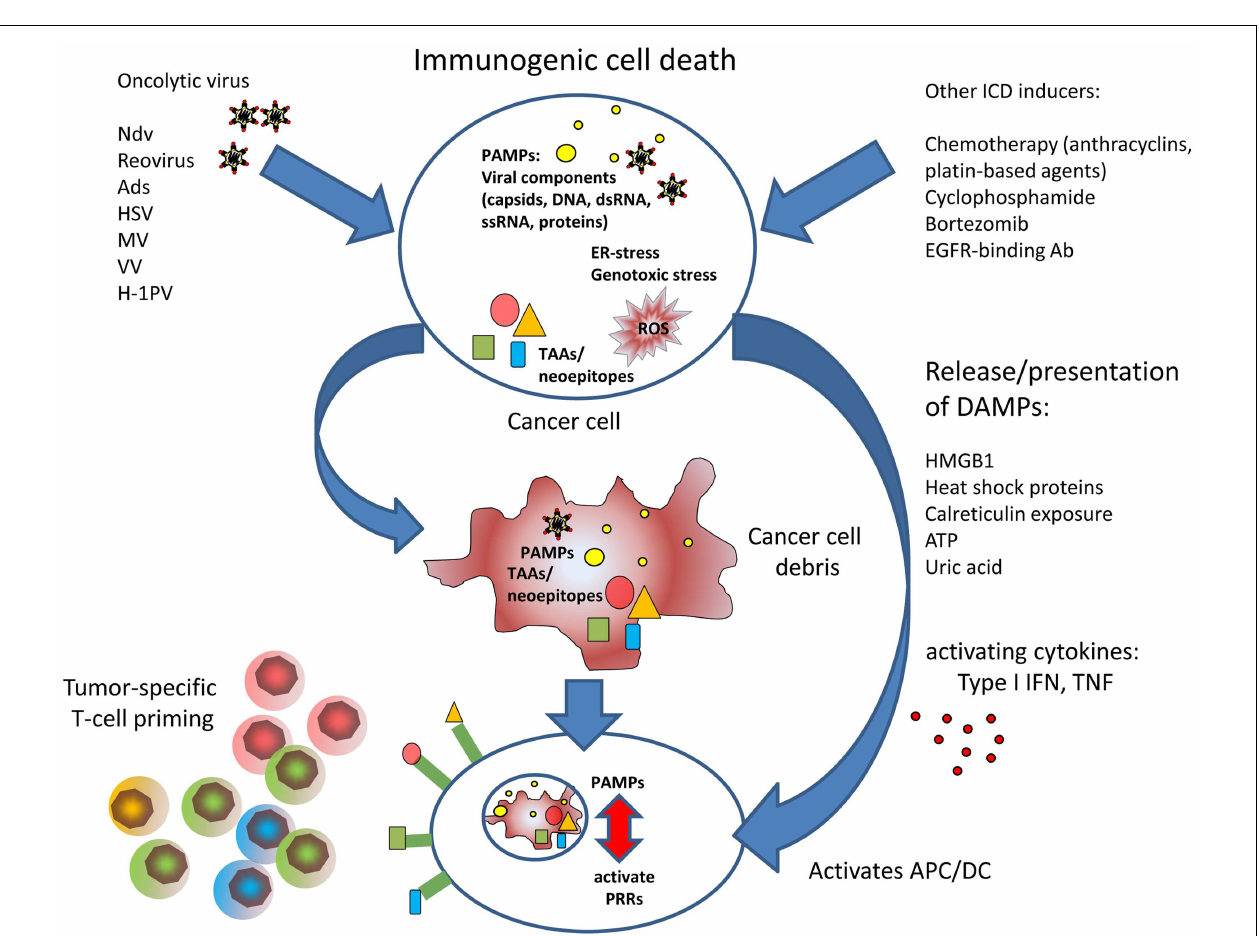
DAMPs activate antigen-presenting dendritic cells that can induce cytotoxicT cell responses against tumor-associated antigens or neoepitopes,